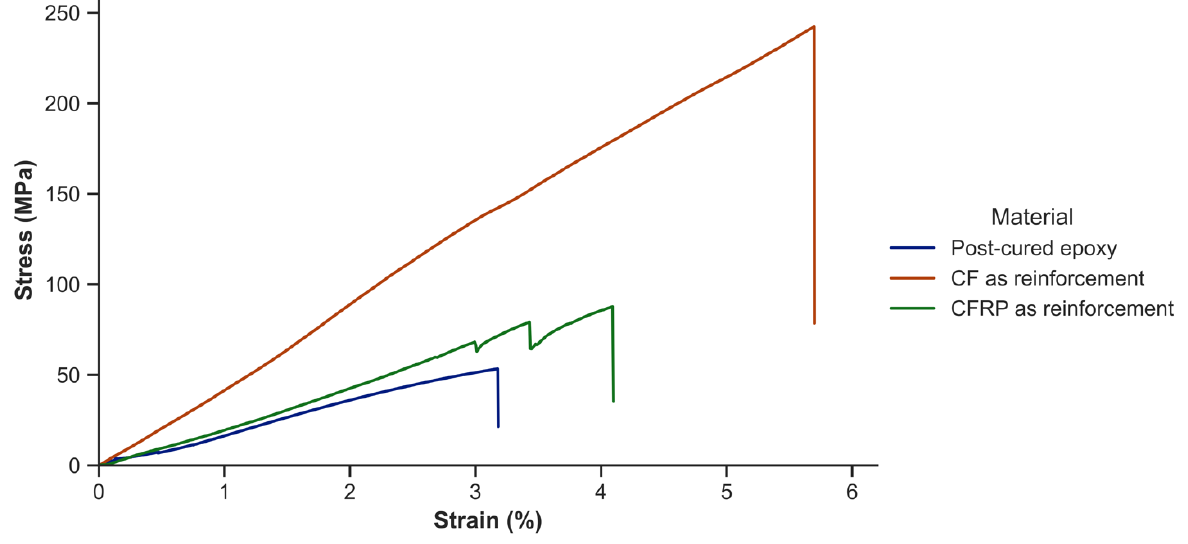
Figure 8. Stress–strain curves for the epoxy resin, carbon fiber reinforced composites and CFRP Figure 8. Stress – strain curves for the epoxy resin, carbon fiber reinforced composites and CFRP re- inforced composites. reinforced